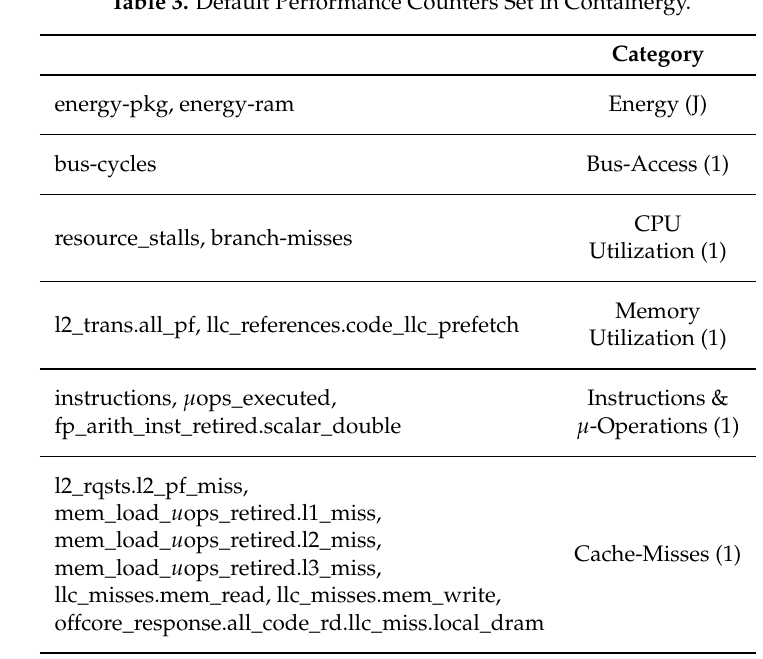
Table 3. Default Performance Counters Set in